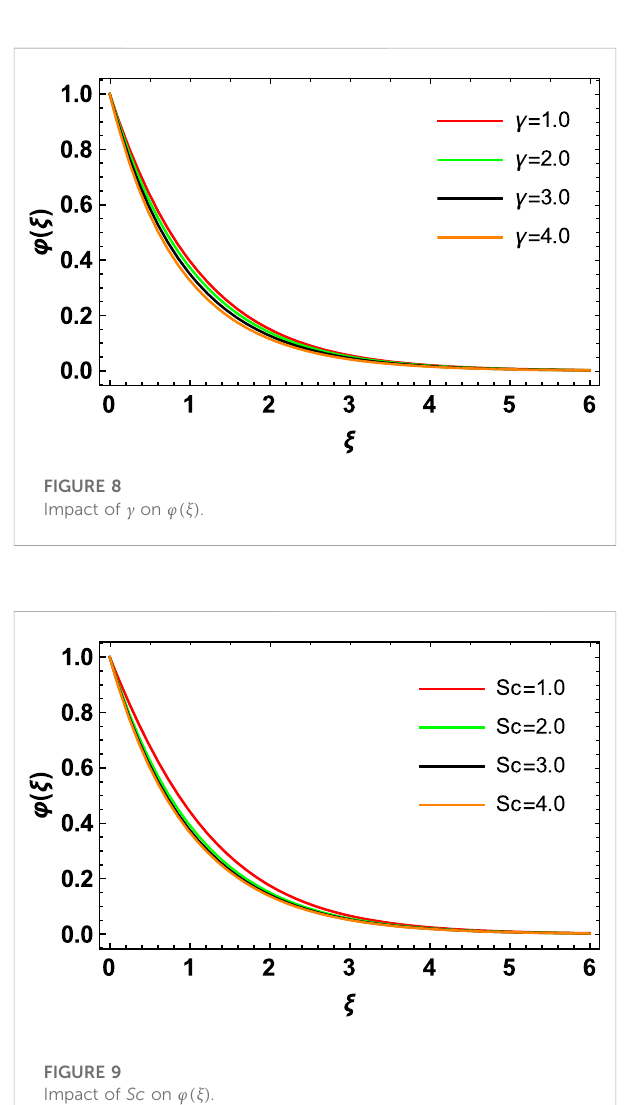
FIGURE 9 Impact of Sc on φ ( ξ )